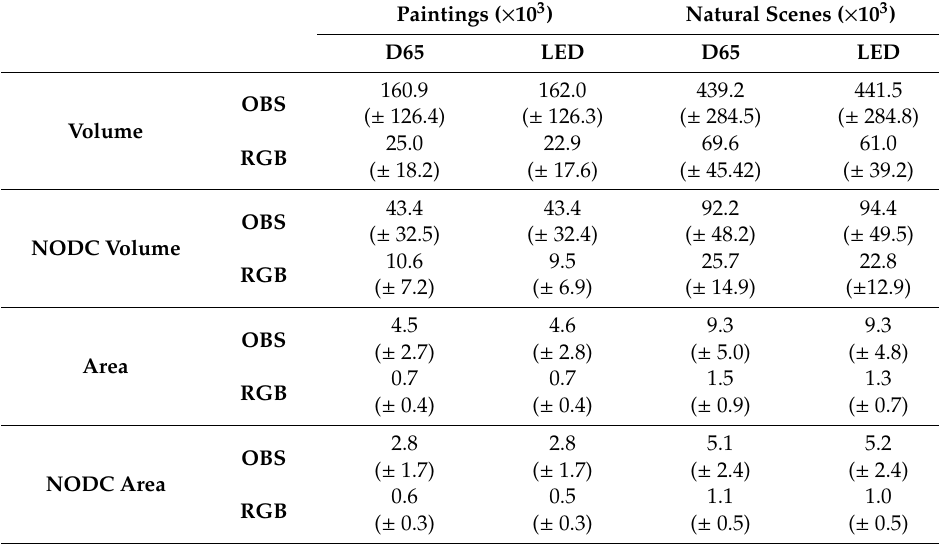
Figure 4. Color gamut in the CIE( a* , b* ) color space generated by all the colors of paintings (light grey line) and natural scenes (dark line), for the CIE 1931 standard observer (OBS, full line) and the digital camera (RGB, dashed line). Data for the CIE D65 (panel ( a )) and the LED (panel ( b )) illuminants. Table 1. Average color volume and correspondent number of discernible colors (NODC) estimated across paintings and natural scenes, for the CIE 1931 standard observer (OBS) and the digital camera (RGB) and the CIE D65 (D65) and LED (LED) illuminants considering the CIELAB color space. Also represented is the gamut area ignoring the L * dimension and the correspondent number of discernible colors. Numbers in brackets represents the standard deviation. Data magnitude is (×10 3 ). Paintings (×10 3 ) Natural Scenes (×10 3 ) D65